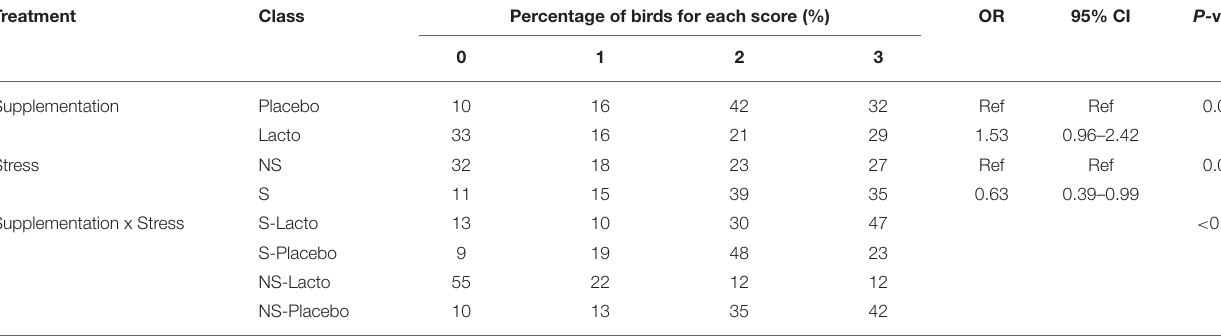
TABLE 1 | Percentage of birds receiving a given score for overall plumage damage within each treatment group.